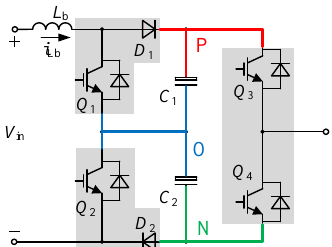
Figure 3. Circuit topology of back-to-back converter.